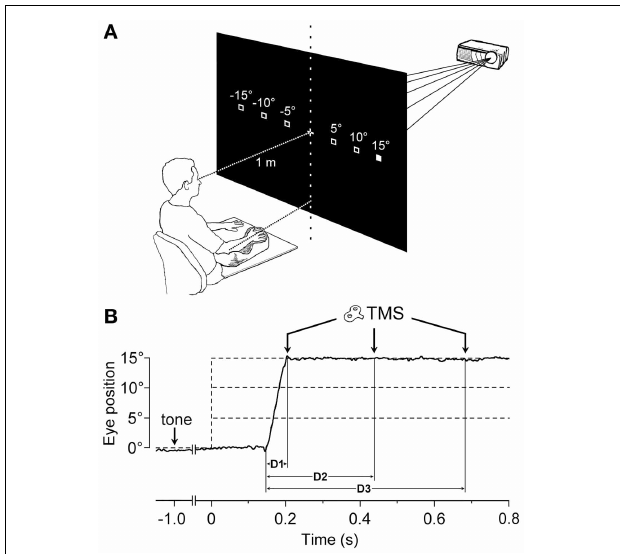
FIGURE 1 | Experimental Setup and Protocol. (A) The target stimulus was projected at one of six possible spatial locations. The filled square represents the actual visual target, while empty squares indicate the other possible positions. The head was immobilized using a chin-rest and a head-support device (not shown). Notice the arm-hand posture imposed on the subject with respect to the central vertical meridian (see text). (B) An EOG recording (solid line) during a representative saccadic eye movement executed toward a 15 ◦ eccentric target. Dashed lines indicate the onset (vertical) and the possible eccentricities (horizontal) of the visual target, which was presented 1000ms after a warning tone. TMS pulses were randomly delivered at 60ms (D1), 300ms (D2), or 540ms (D3) after the beginning of the